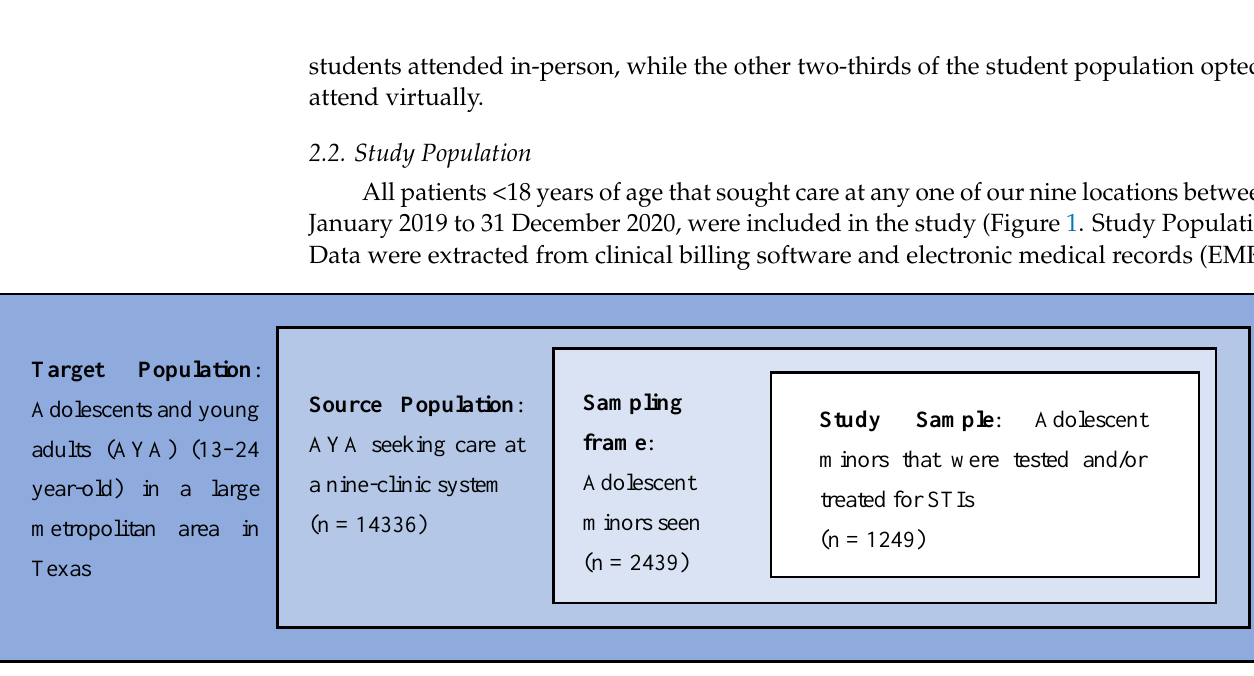
Figure 1. Study Figure 1. Study Population